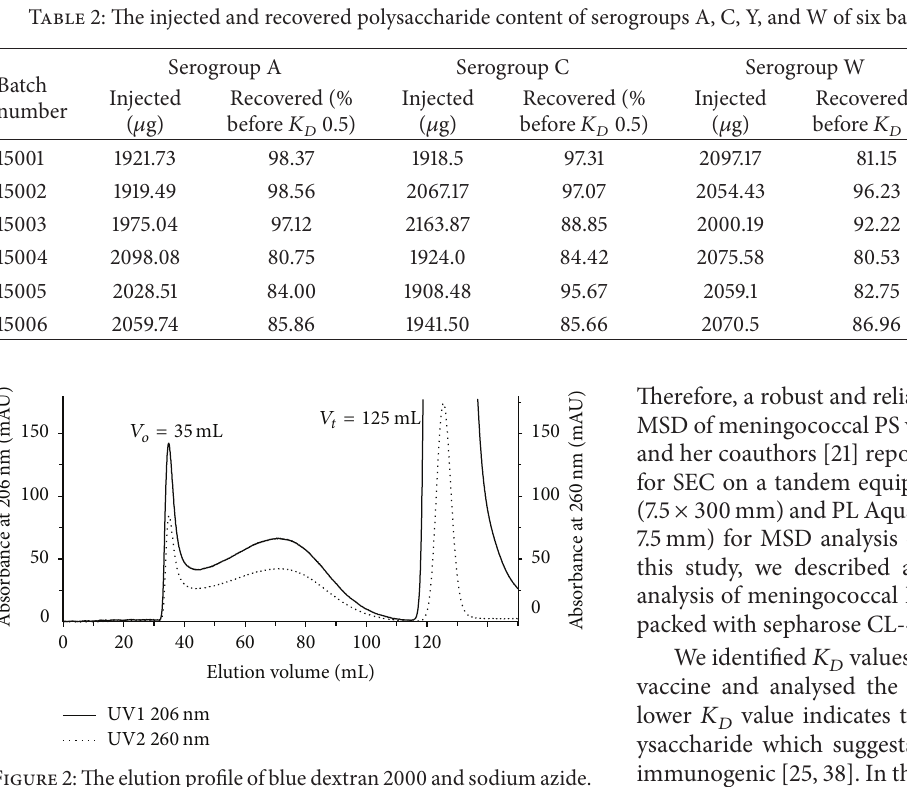
Figure 2: The elution profile of blue dextran 2000 and sodium azide. The absorbance of blue dextran 2000 was monitored at 206 nm and sodium azide at 260